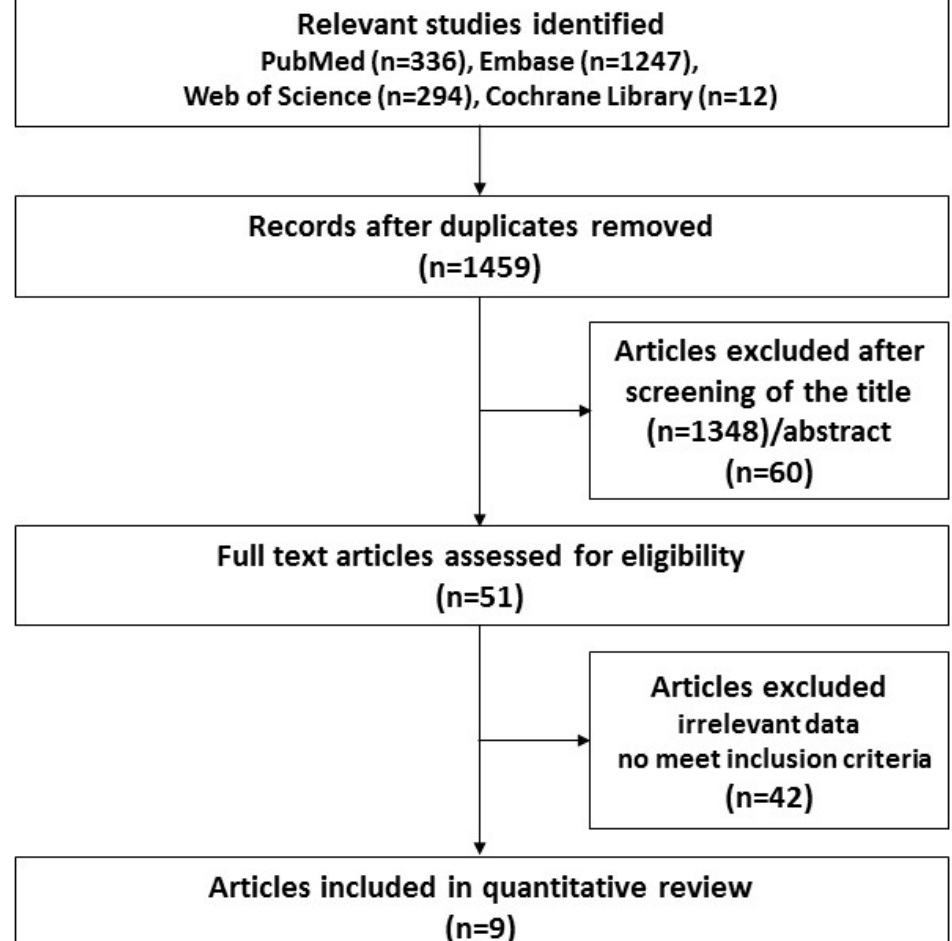
Figure 1. Flow chart for the study selection process.